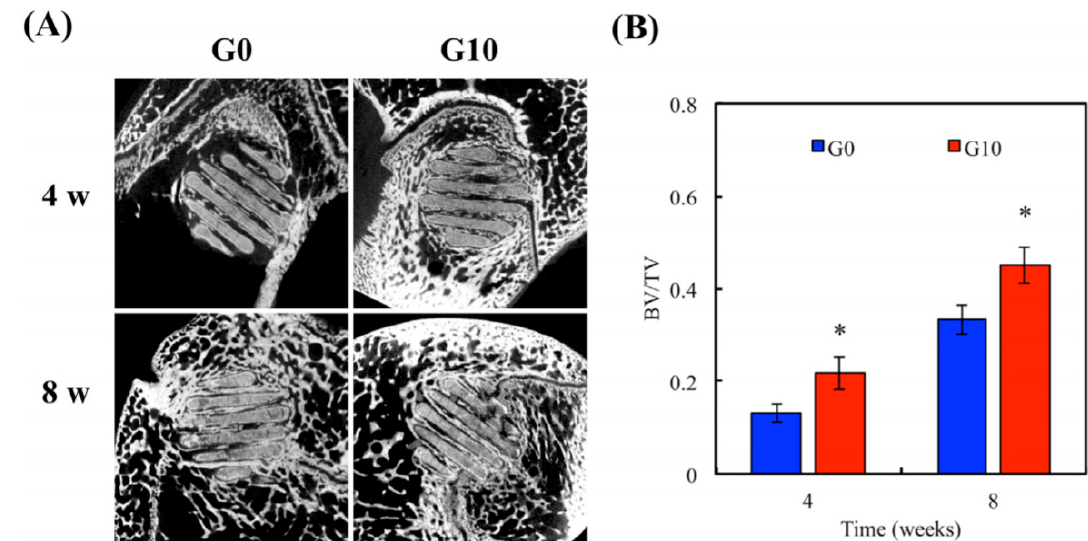
Figure 11. ( A ) Morphology of bone growth on CS/PCL scaffold with (G10) and without (G0) graphene manufactured by FDM. Images took by μ -CT. ( B ) Relative bone mass volume (BV/TV) at fixed-sized critical lesion ar different times. It is seen how the presence of G increased the bone growth rate (reprinted from [68], with permission from Elsevier).